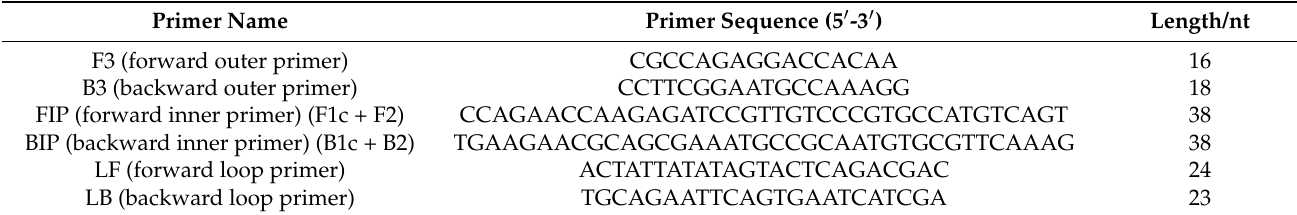
Table 1. Sequences of the LAMP primers used for amplification of the target sequence in ITS region. Primer